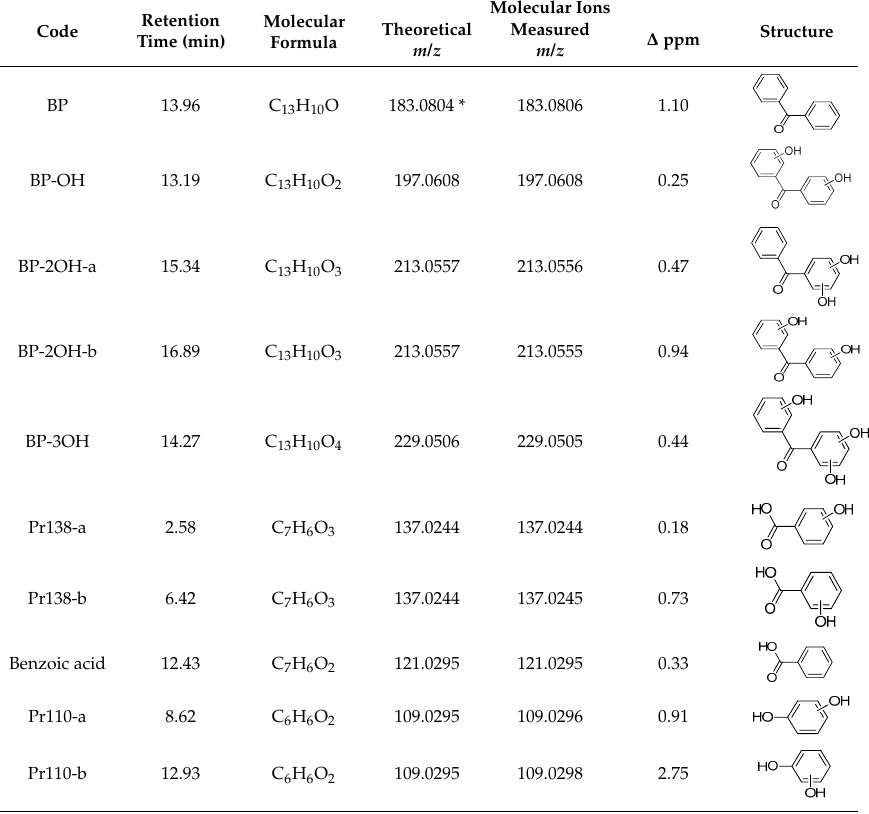
Table 4. Molecular formula and properties of BP and its degradation products.